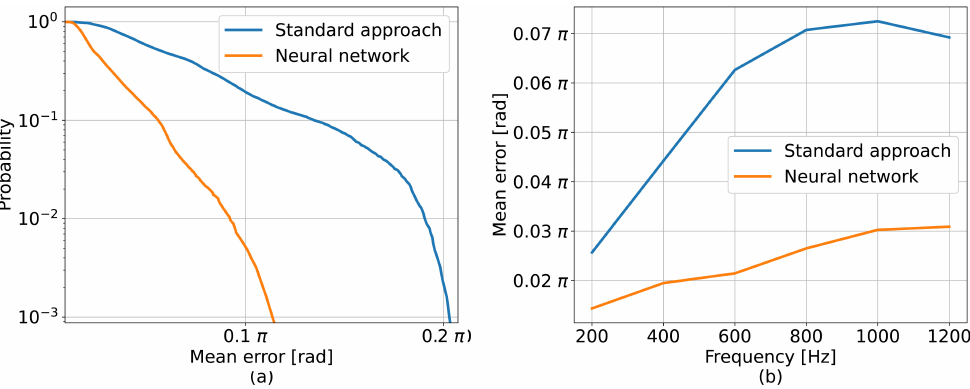
Figure 2. ( a ) Survival function for mean errors between the detected phases and their best fits. ( b ) Relationship between mean best fit error and